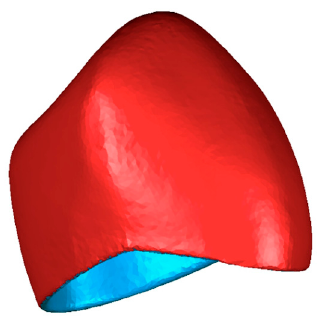
Figure 2. The STL file of the scanned prefabricated polycarbonate crown, which served as a template for CNC